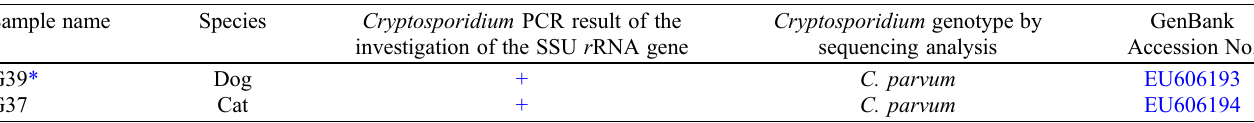
Table 2. Positive household animals for the presence of Cryptosporidium genotypes by PCR of the SSU r RNA and sequencing analysis results ( n = 19 cats and n = 81